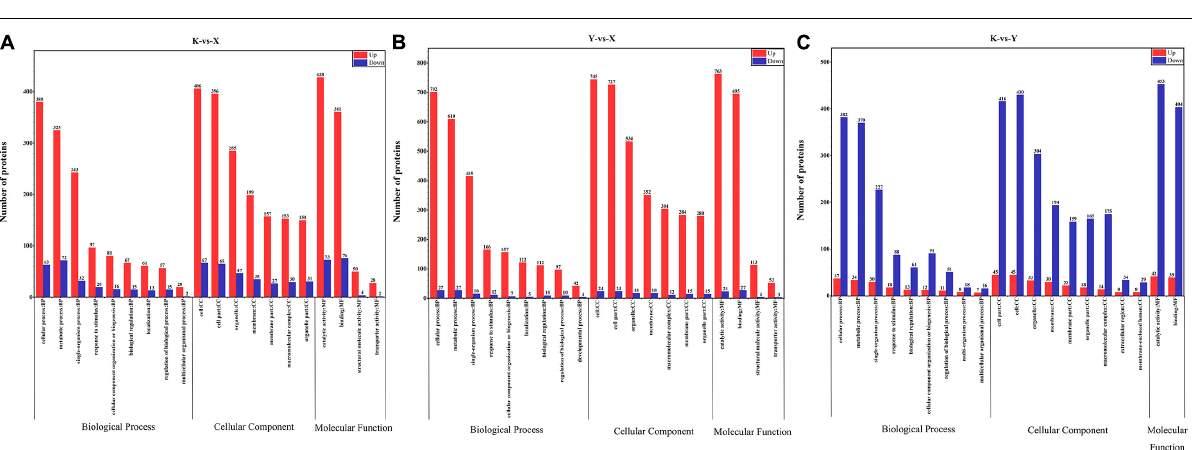
amino sugar and nucleotide sugar metabolism, and riboflavin metabolism ( Figure 7C ). These biochemical metabolism pathways will help us to further understand the physiological changes of rhubarb during the drying